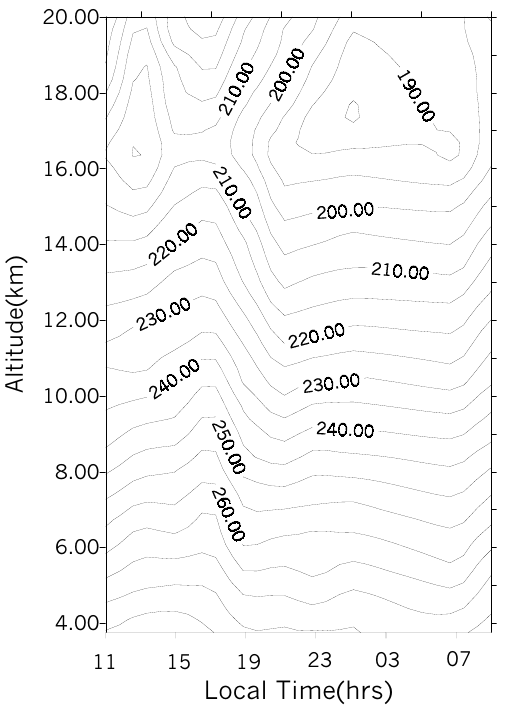
Fig. 4. Diurnal evolution of the vertical profile of temperature dur- ing 24–25 August 1998.